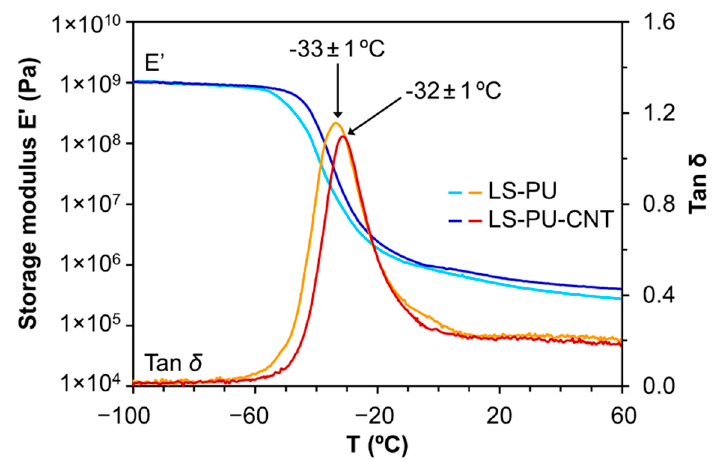
Figure 2. DMA profiles of LS, LS-based PU (LS-PU), and LS-based PU doped with 1% w / w MWCNTs (LS-PU-CNT).